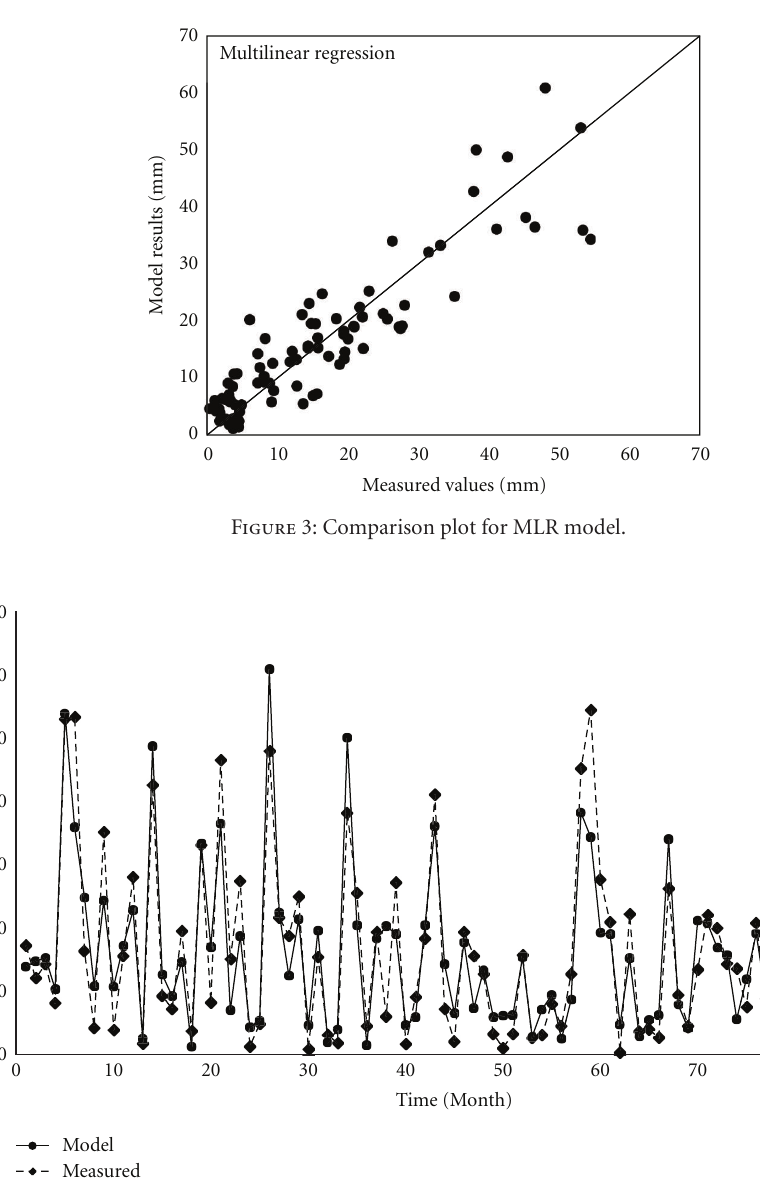
Figure 4: Time series for MLR